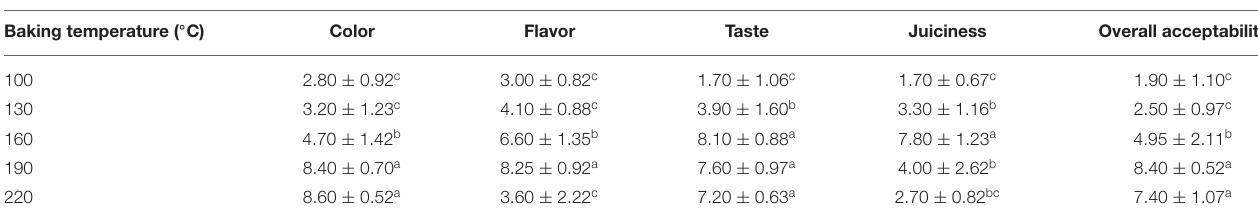
Frontiers in Nutrition |